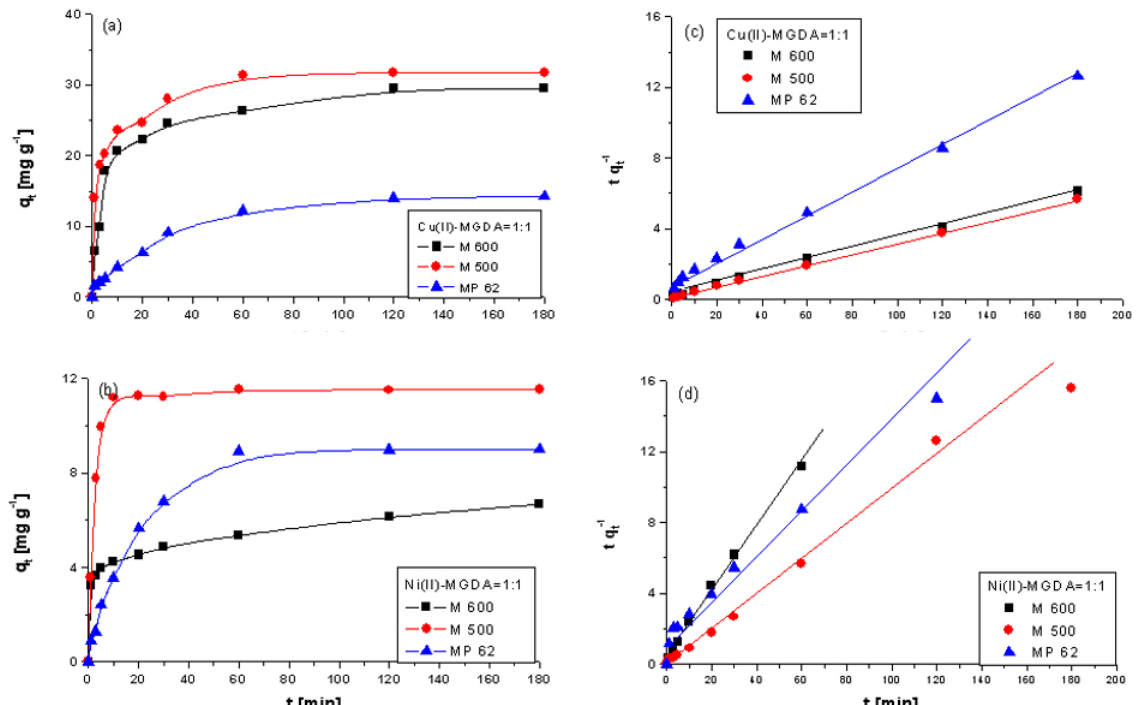
Figure 2. Comparison of the sorption capacity depending on the phase contact time (a-b) and the pseudo second order kinetic (c-d) for the Cu(II) and Ni(II) complexes with MGDA on Lewatit MonoPlus M 600, Lewatit MonoPlus M 500 and Lewatit MP